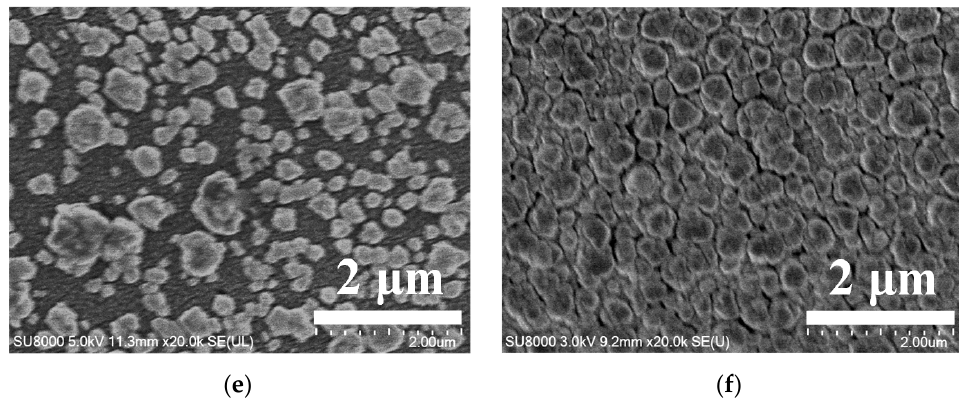
Figure 5. SEM micrographs of Au solid contact layers at Au 3+ concentrations of 1 mM ( a ), 2 mM ( b ), 2.5 mM ( c ), 3 mM ( d ), 4 mM ( e ), and 5 mM ( f ) of the electrolyte, respectively.